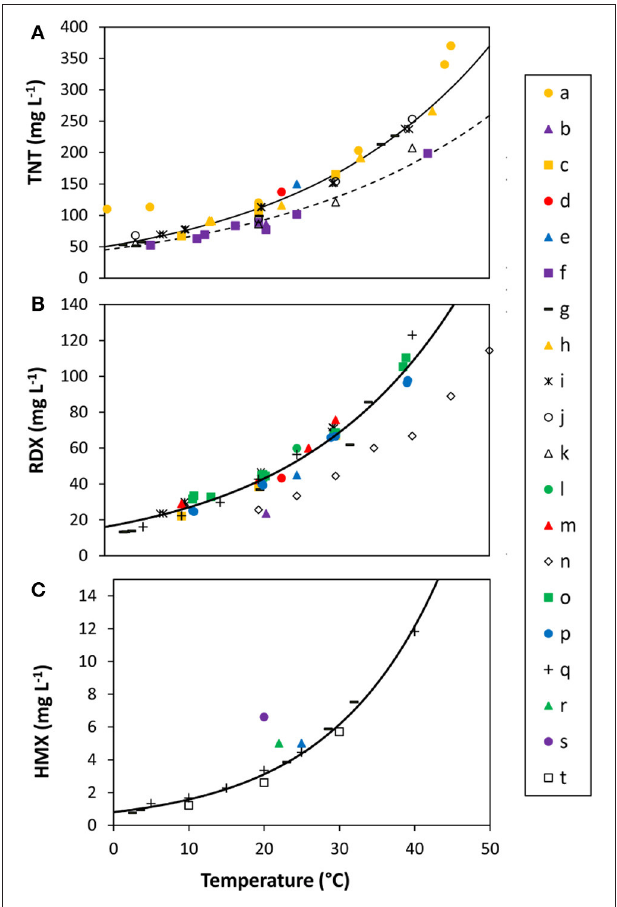
FIGURE 4 | MC solubility as a function of temperature. (A) TNT, (B) RDX, (C) HMX. Solid (freshwater) and dashed (seawater) lines represent visual fits to the data, omitting apparent outliers, according to the exponential model used by Bier et al. (1999) (Solubility = a*e bT ; coefficients are given in Table 2 ). Letters identify data sources: a, Taylor and Rinkenbach (1923); b, Hale et al. (1979) ; c, Spanggord et al. (1983); d, Leggett (1985); e, Rosenblatt et al.